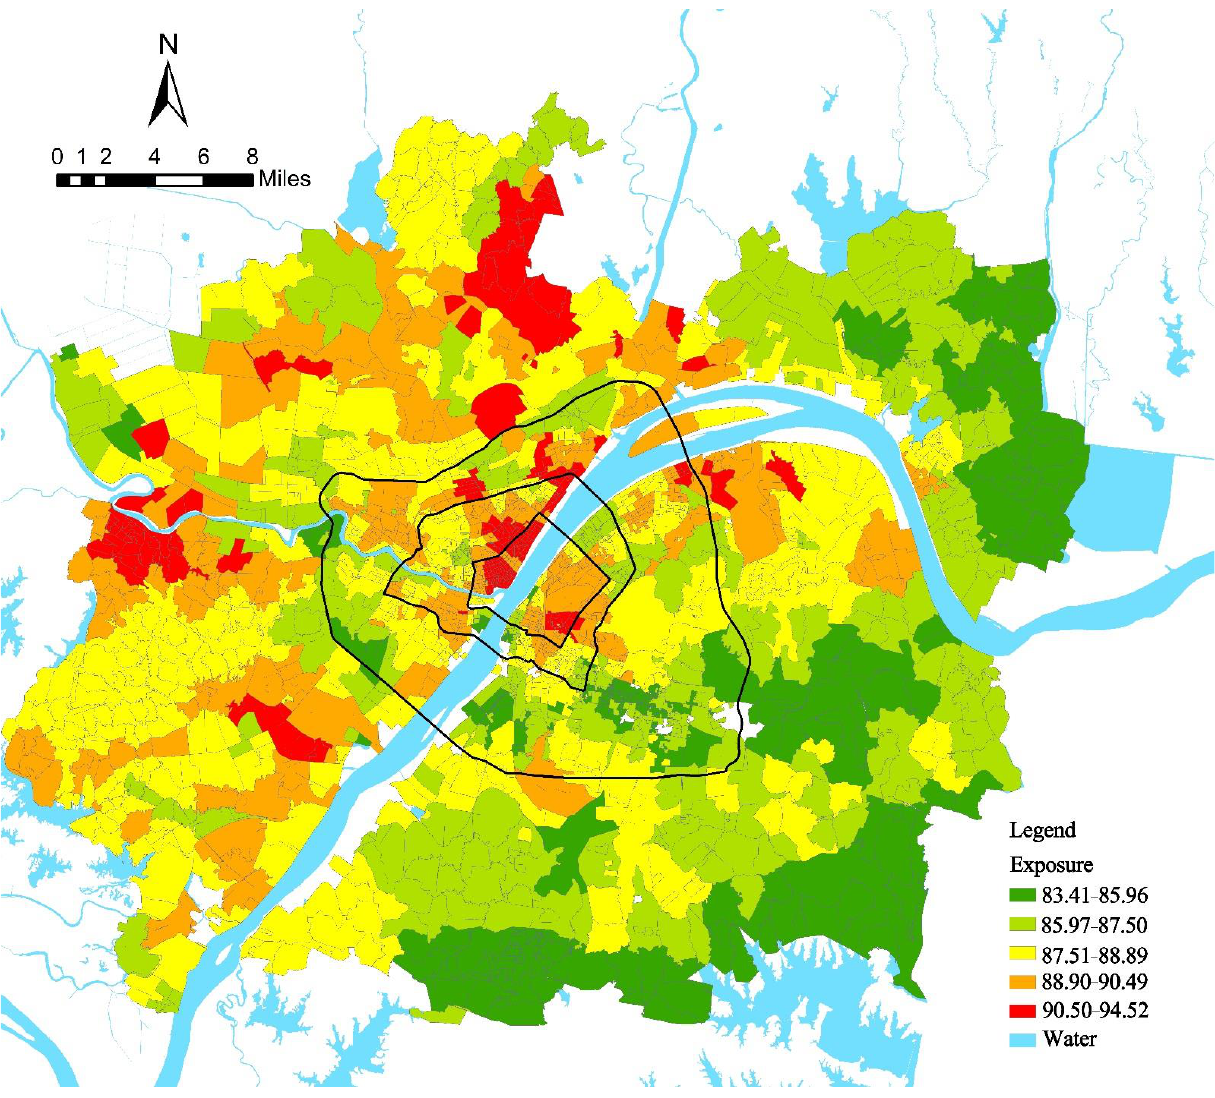
Figure 5. Spatial distribution of weighted PM 2.5 concentration.